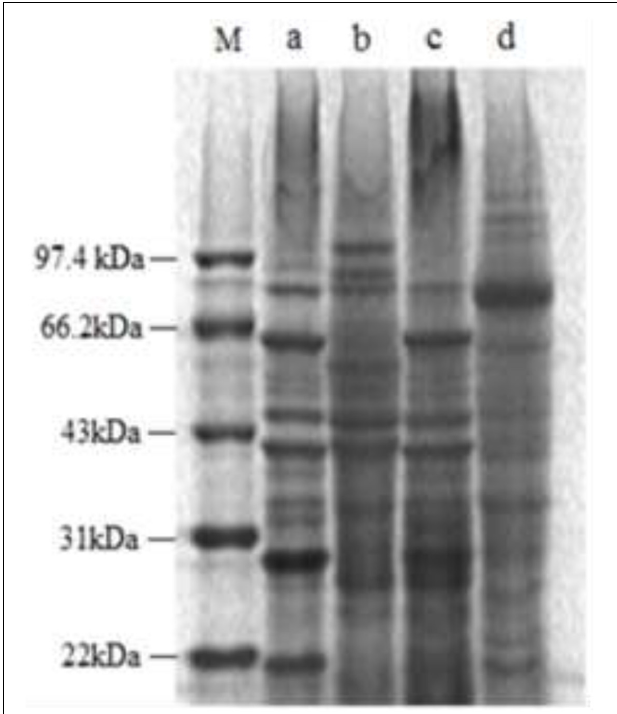
FIGURE 7 | SDS-PAGE electropherogram of the two indicator bacteria, the molecular marker (M), the E. coli used as control (a), the treated E. coli (b), the S. aureus used as control (c), the treated S. aureus (d).